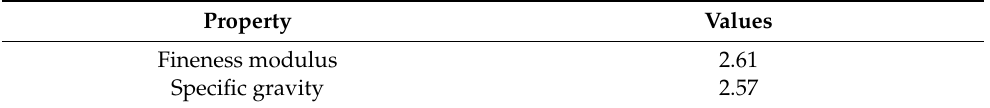
Table 2. Property of fine aggregate .